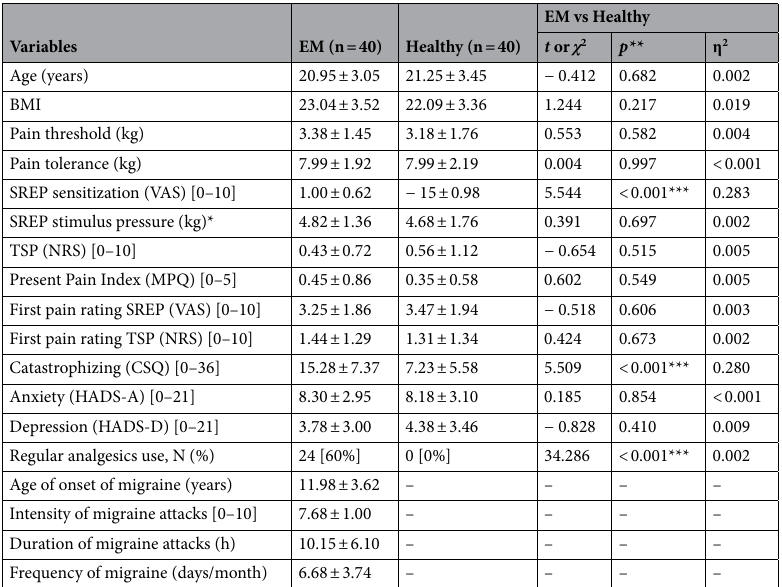
Table 1. Demographic, clinical, and evoked pain data by group for episodic migraine patients and healthy individuals. Means ± Standard Deviations, and results of the group comparisons ( t or χ 2 , p, and η 2 ). *Individually calibrated stimulus pressure for the SREP procedure in kg/cm2. **Original p -values from group comparisons. ***Significant p -values after Bonferroni adjustment remained below 0.001. BMI Body Mass Index, CSQ Coping Strategies Questionnaire, EM Episodic Migraine, HADS Hospital Anxiety and Depression Scale, MPQ McGill Pain Questionnaire, NRS Numeric Rating Scale, SREP Slowly Repeated Evoked Pain, TSP Temporal Summation of Pain, VAS Visual Analogic